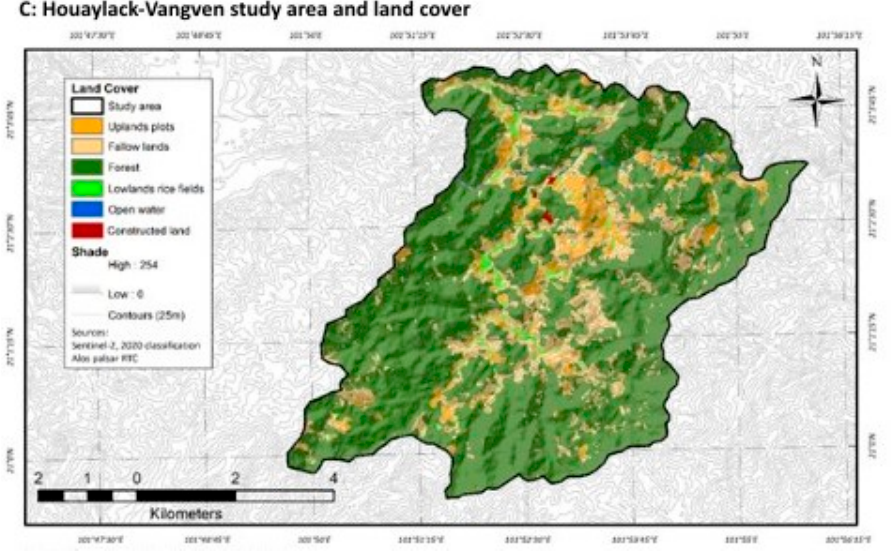
Figure 1. Study area (Houaylack-Vangven village and surrounding areas).